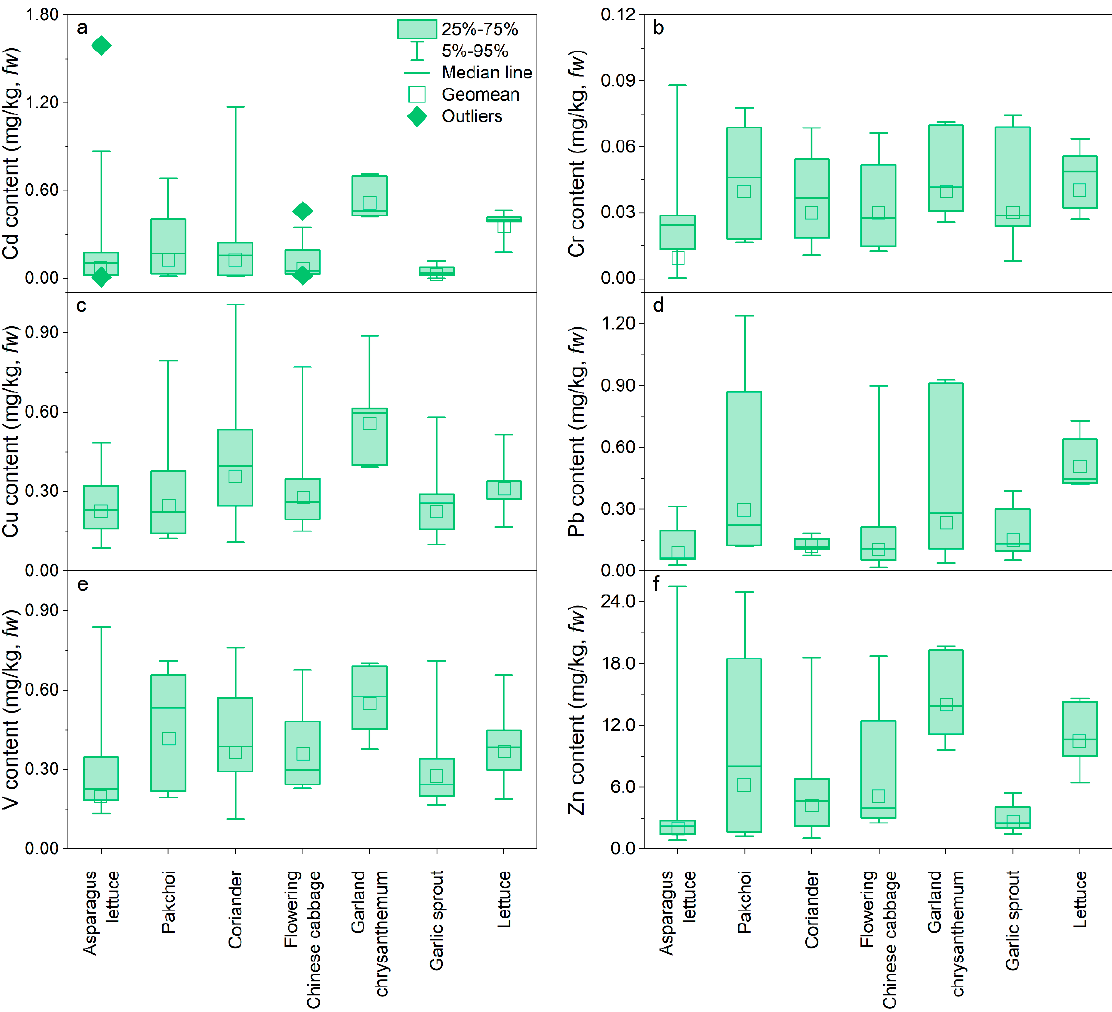
Figure 4. The trace metal contents in vegetables around the V-containing stone coal smelting site. ( a – f ) represents the content of Cd, Cr, Cu, Pb, V, and Zn, respectively.